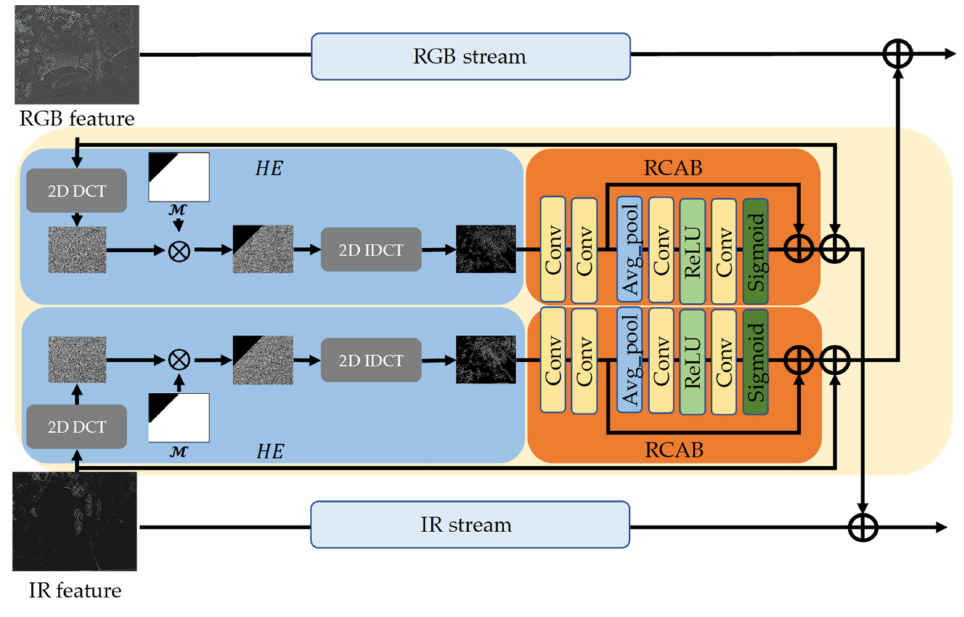
Figure 6. Architecture of the high-frequency assistant